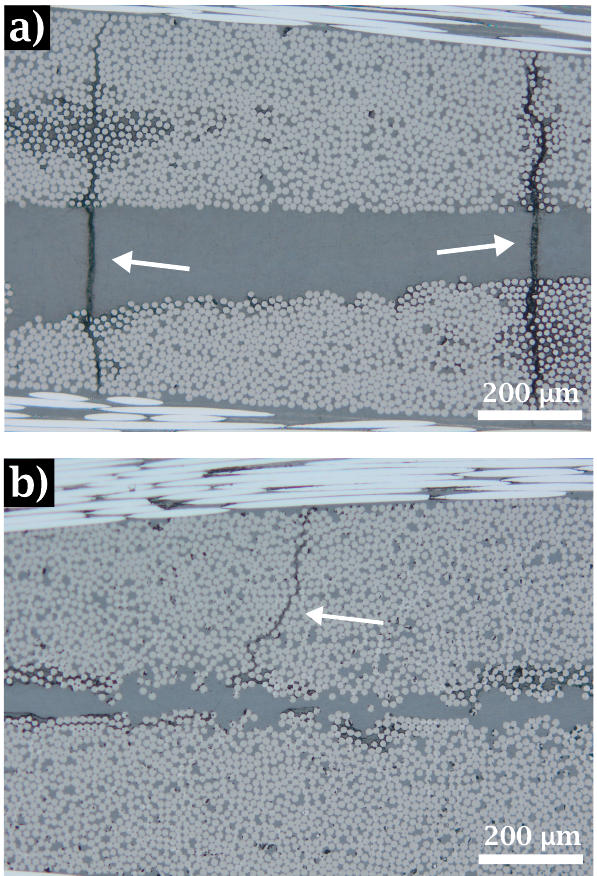
Figure 16. Images of the laminate cross-section (post-mortem). The samples obtained corresponds to different materials: ( a ) Lam 0 ± 45 ◦ and ( b ) Lam I ± 45 ◦ . White arrows show the cracking